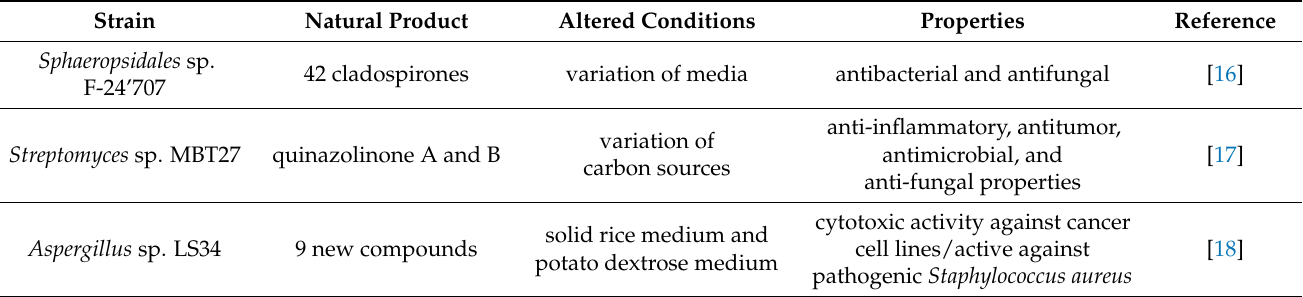
Table 1. Summary of new pharmaceutically active compounds obtained by altering culture conditions in one strain many compounds (OSMAC) screening